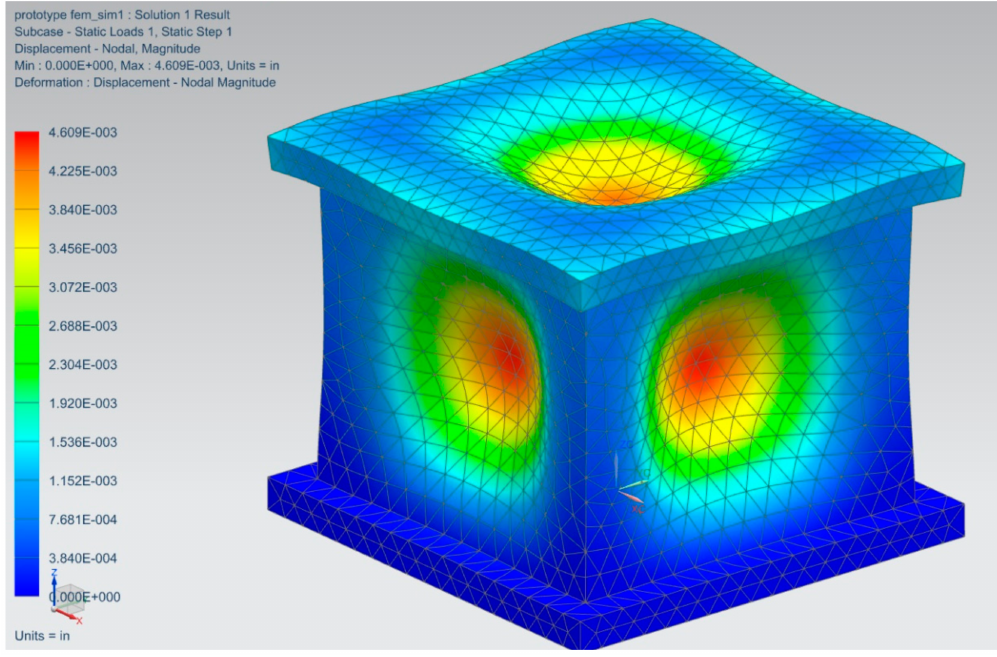
Figure 3. The chamber base